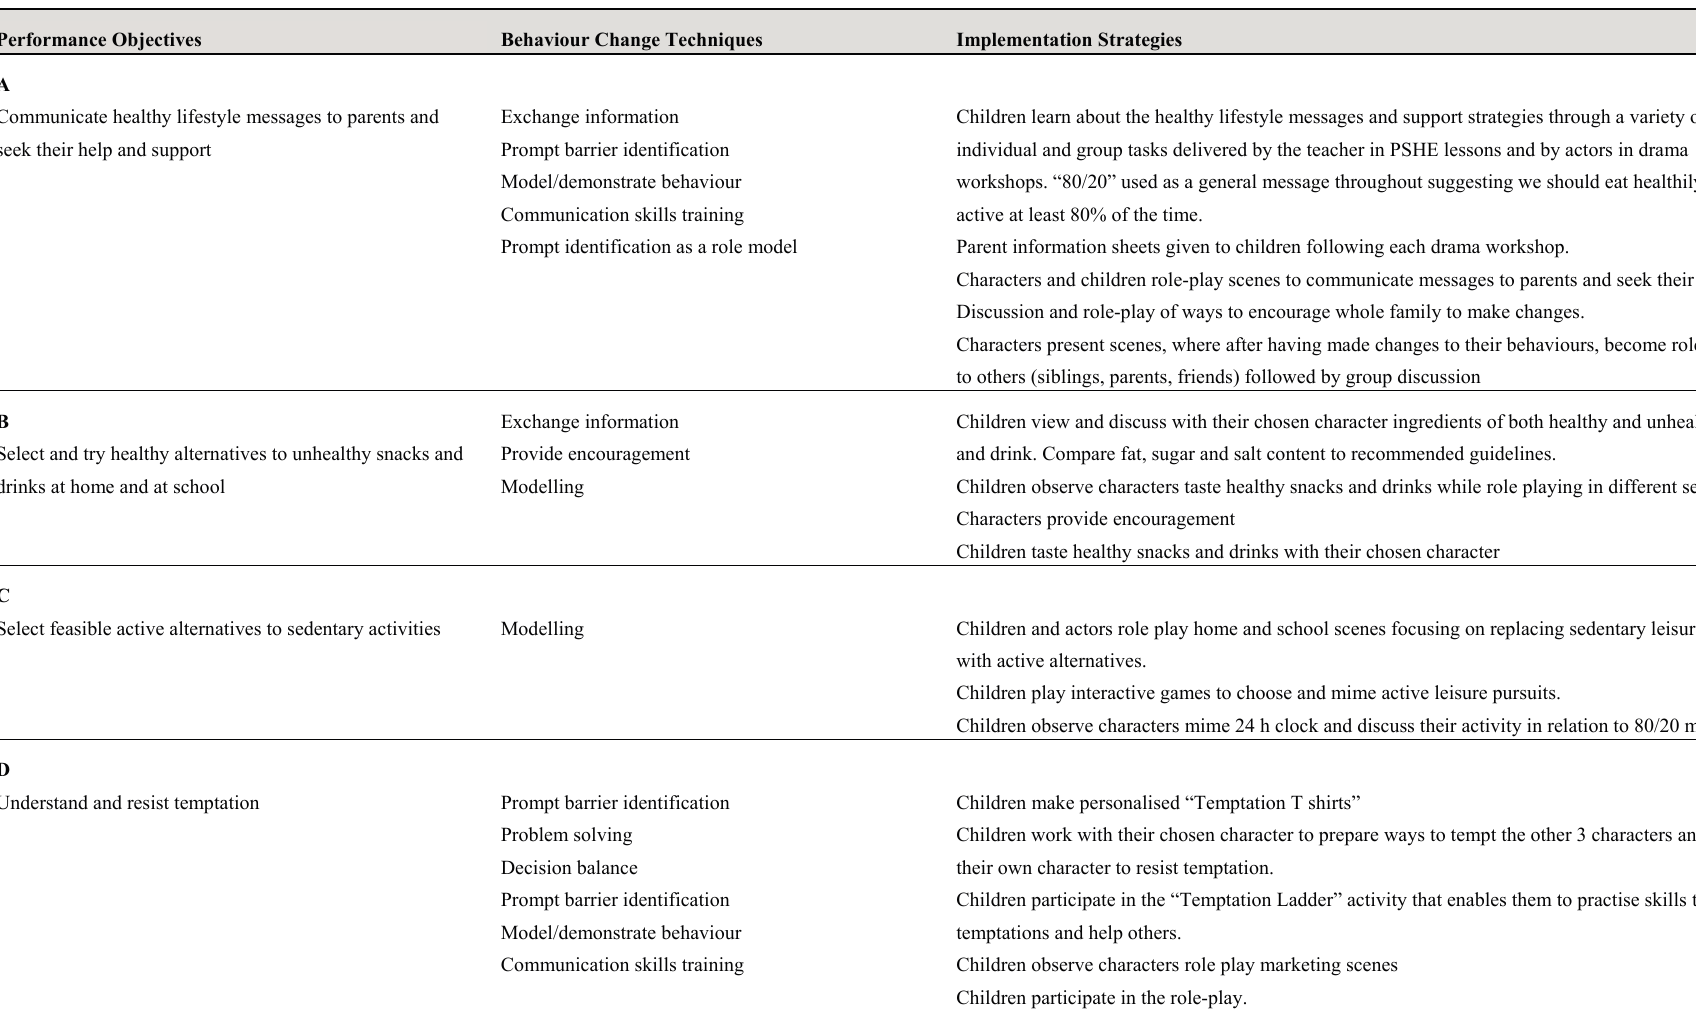
Table 2. “Establish Motivation”: associated behaviour change techniques and strategies for performance